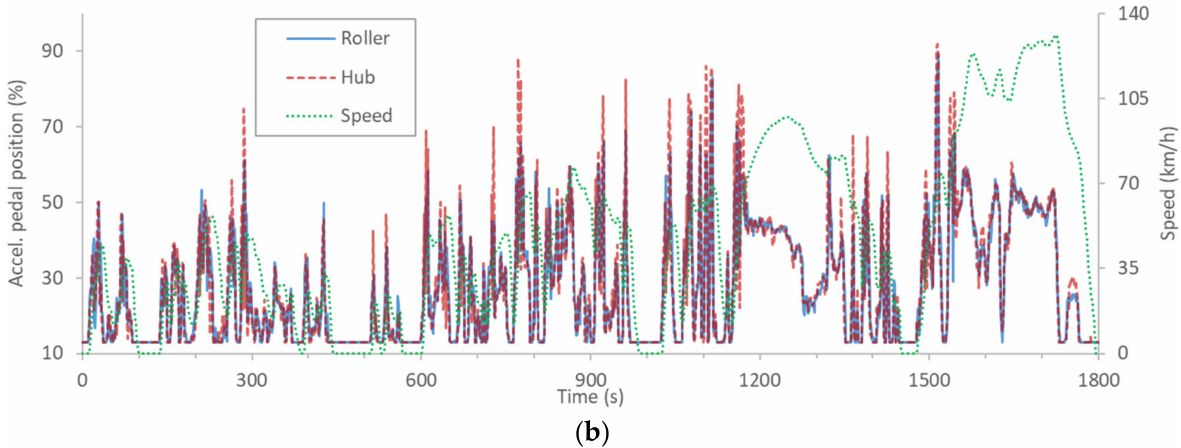
Figure 2. Real time recordings: ( a ) Speed traces. ( b ) Accelerator pedal position with the roller-type and hub-type dynamometers (cold-start WLTC).